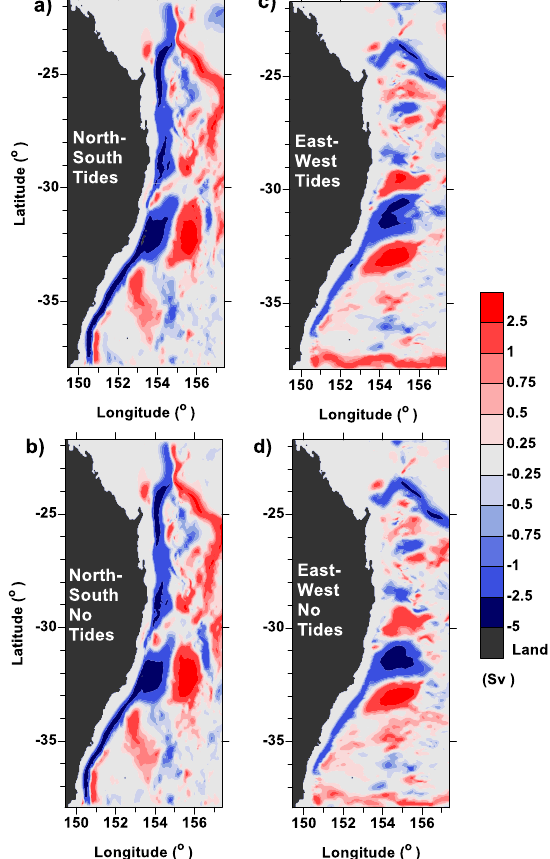
Fig. 2 Mean barotropic transports over time in the a North–South and c East–West velocities with tides in the simulation and b and d without tides,